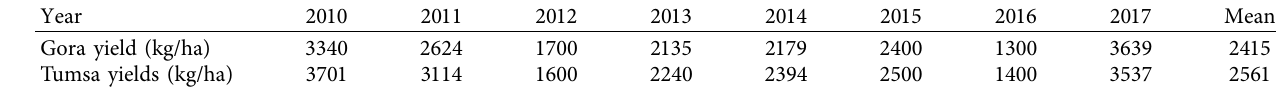
Table 1: Faba bean yield (Gora and Tumsa) varieties production in kg/ha for the study area.